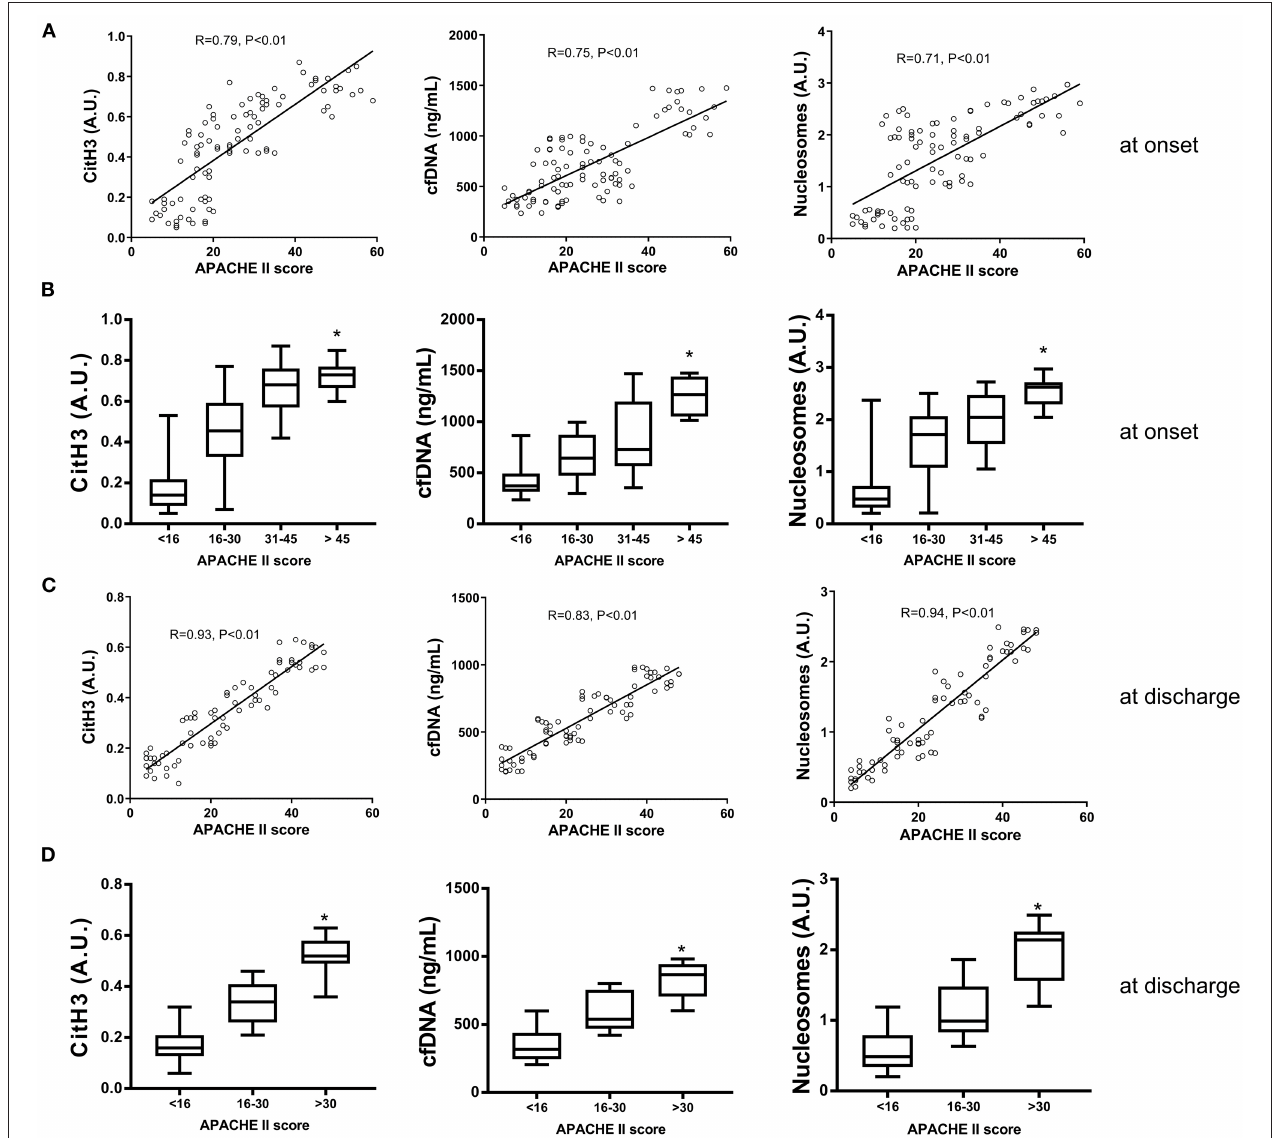
FIGURE 2 | The association between NET markers and disease severity of AAD at onset and discharge. (A) Serum levels of citH3, cfDNA and nucleosomes were positively correlated with the APACHE II score at disease onset. (B) AAD patients were classified into four groups according to APACHE II score. Patients with higher scores had significantly higher levels of all three NET markers. (C) The levels of all three NET markers were positively correlated with the APACHE II score at discharge. (D) AAD patients with greater disease severity showed significantly higher levels of NET markers. * P <